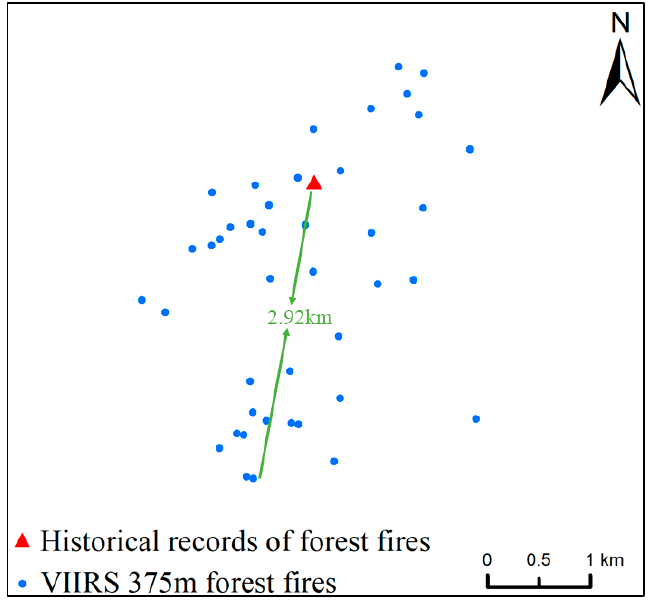
Figure 2. Example of matching VIIRS forest fires with historical forest fires.